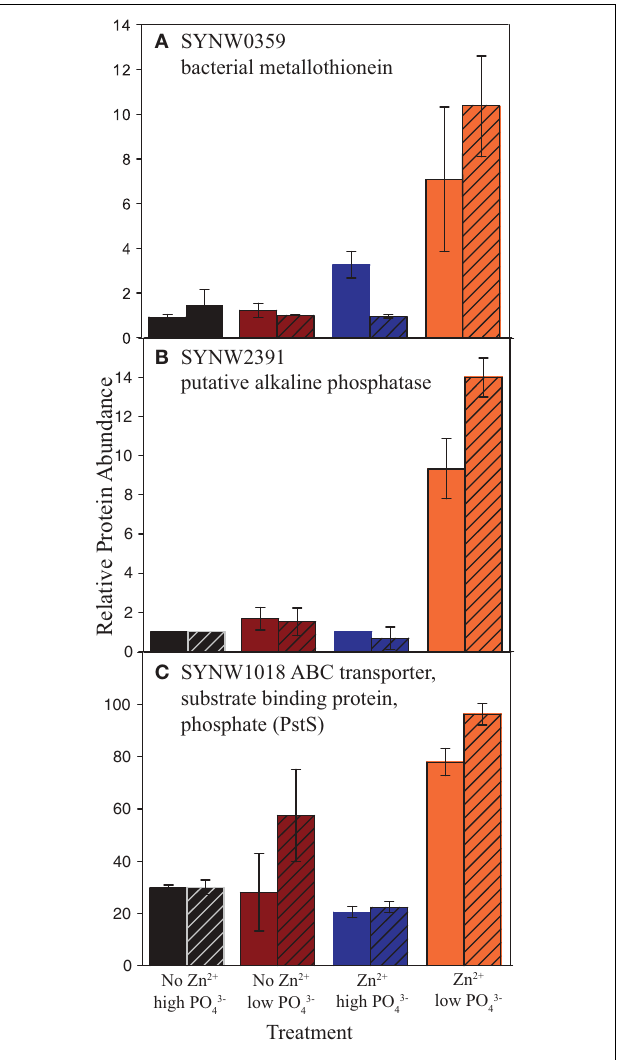
FIGURE 7 | Relative protein abundances of SYNW0359 bacterial metallothionein, SYNW2391 putative alkaline phosphatase, and SYNW1018 ABC transporter, substrate binding protein, phosphate (PstS). Hatched bars were subjected to short-term Cd additions. Error bars are the standard deviation of duplicate injections. Note greater relative abundances of the alkaline phosphatase and PstS in the 1 μ M PO 43 − compared to the 65 μ M PO 43 − treatments. Note the greater relative abundances of the alkaline phosphatase in the 1 μ M PO 43 − treatments with Zn compared to no